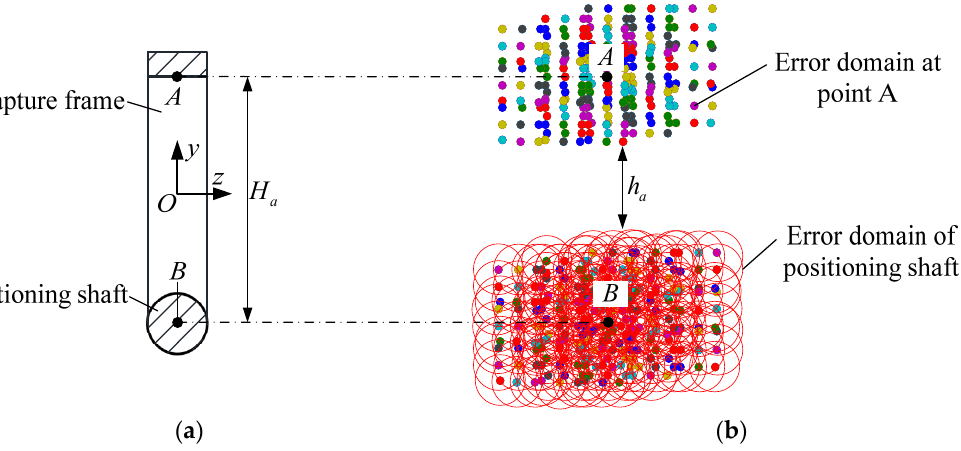
Figure 9. Schematic diagram of capture frame error field. ( a ) Capture box cutaway view; ( b ) schematic diagram of the key point error field. ( A : The top plate center of capture frame; B : The positioning shaft center of capture frame.)